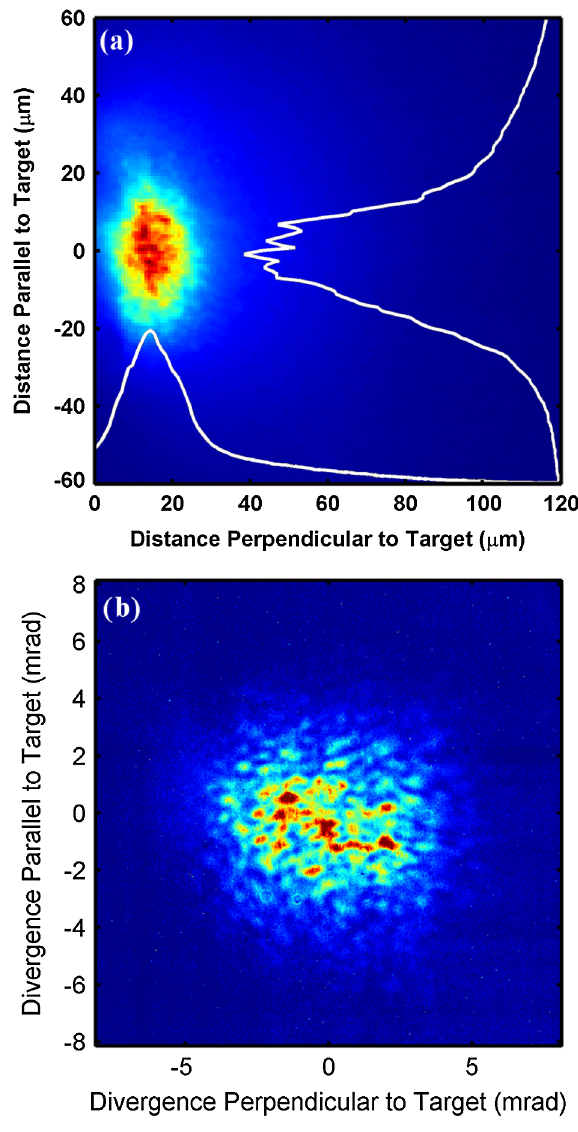
FIG. 3. Characteristics of the (cid:1) ¼ 8 : 85 nm lanthanum laser. (a) Measured near-field pattern. The center of the laser beam at the amplifier exit is 14 (cid:2) m from the target. (b) Measured far-field pattern at a distance of 0.83 m from the